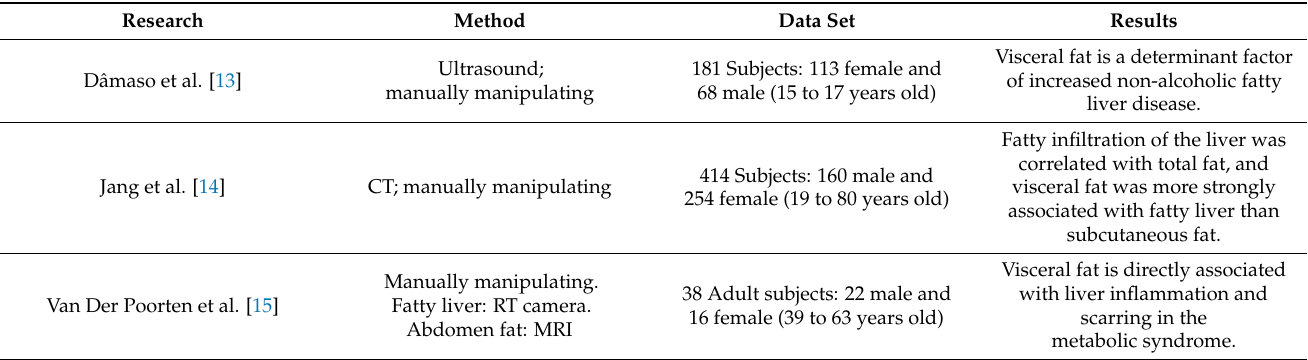
Table 1. Obesity and fatty liver correlation study